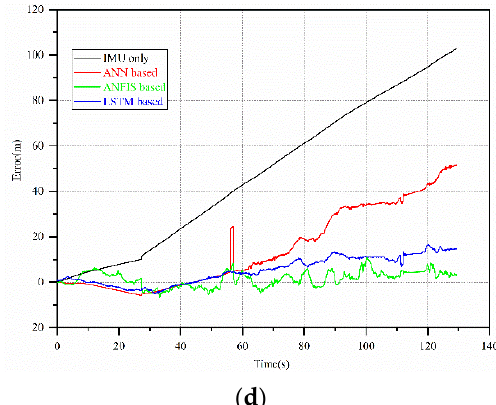
Figure 5. Error accumulation curve of three algorithms: ( a ) X-direction position error in the b 0 system; ( b ) Y-direction position error in the b 0 system; ( c ) east direction position error in the n system; ( d ) north direction position error in the n system. Table 3. Error statistics of three algorithms in the b 0 system.